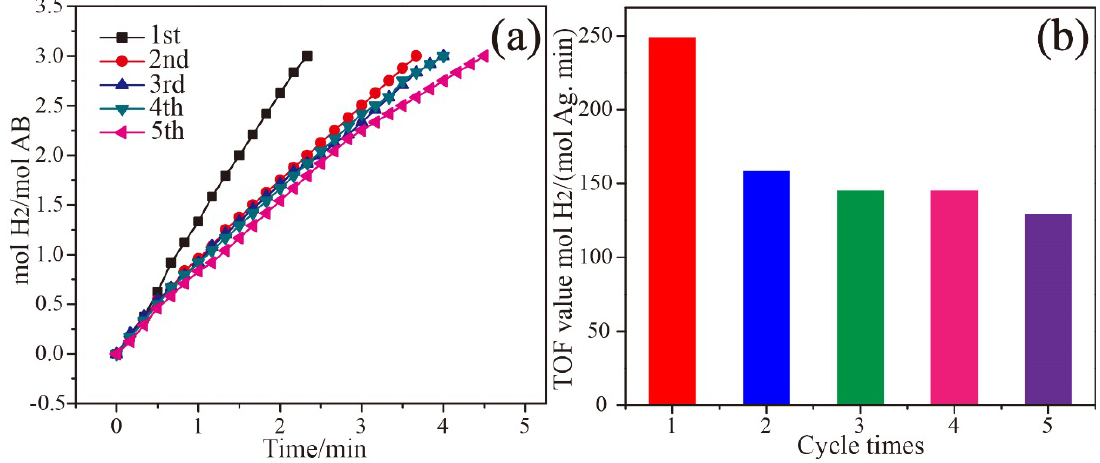
Figure 5. ( a ) The plots of mol H 2 /mol AB versus time during the catalyst stability tests. ( b ) The TOF values for AB hydrolysis over Ag 0.1 Co 0.9 /g-C 3 N 4 after each cycle.